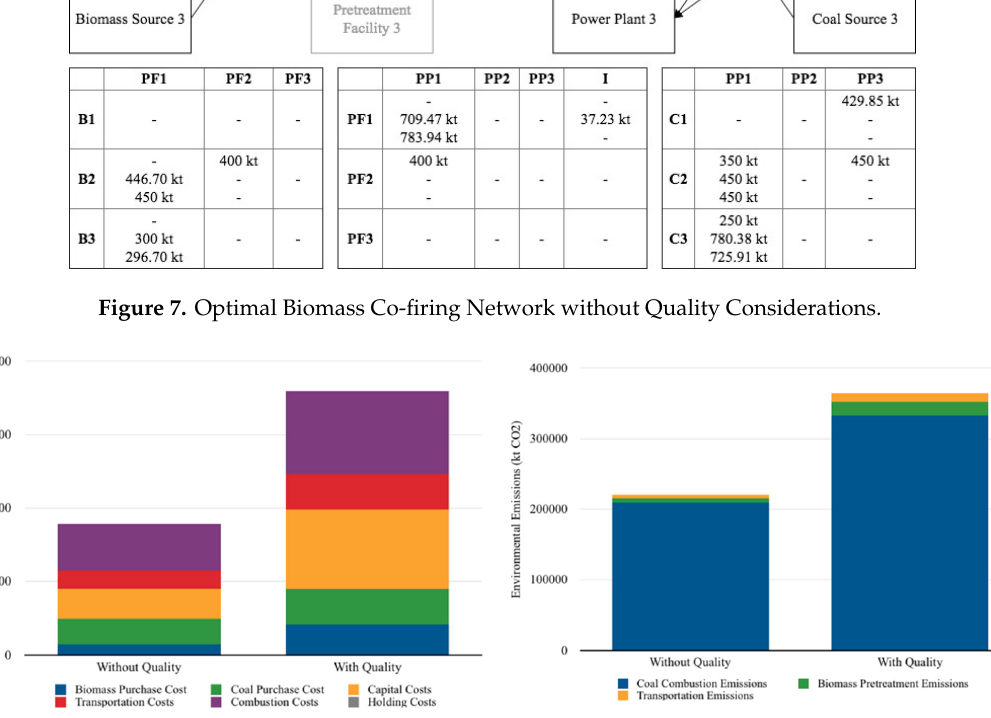
( b ) Figure 9. Breakdown of ( a ) costs and ( b ) environmental when Biomass Properties are Varied. It can be observed that costs and emissions increase as the properties of biomass worsen. The improved properties scenario yielded the least cost and environmental emissions, while the worsened properties scenario resulted in higher costs and emissions. The breakdown of costs is analysed in Figure 9a to understand why costs increased as properties worsened. With worse biomass quality, efficiency loss experienced by the conversion equipment in coal power plants also worsen, requiring the system to purchase and use more fuel. This increases all cost components, such as fuel purchase costs, transport, pre-treatment, and combustion costs. Transportation costs also increase because of the worse bulk density of the biomass, requiring